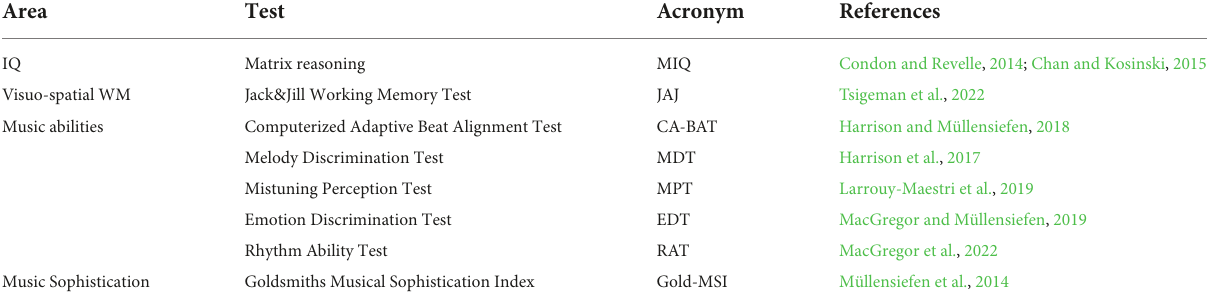
TABLE 1 LongGold tests employed in the MiddleMusic